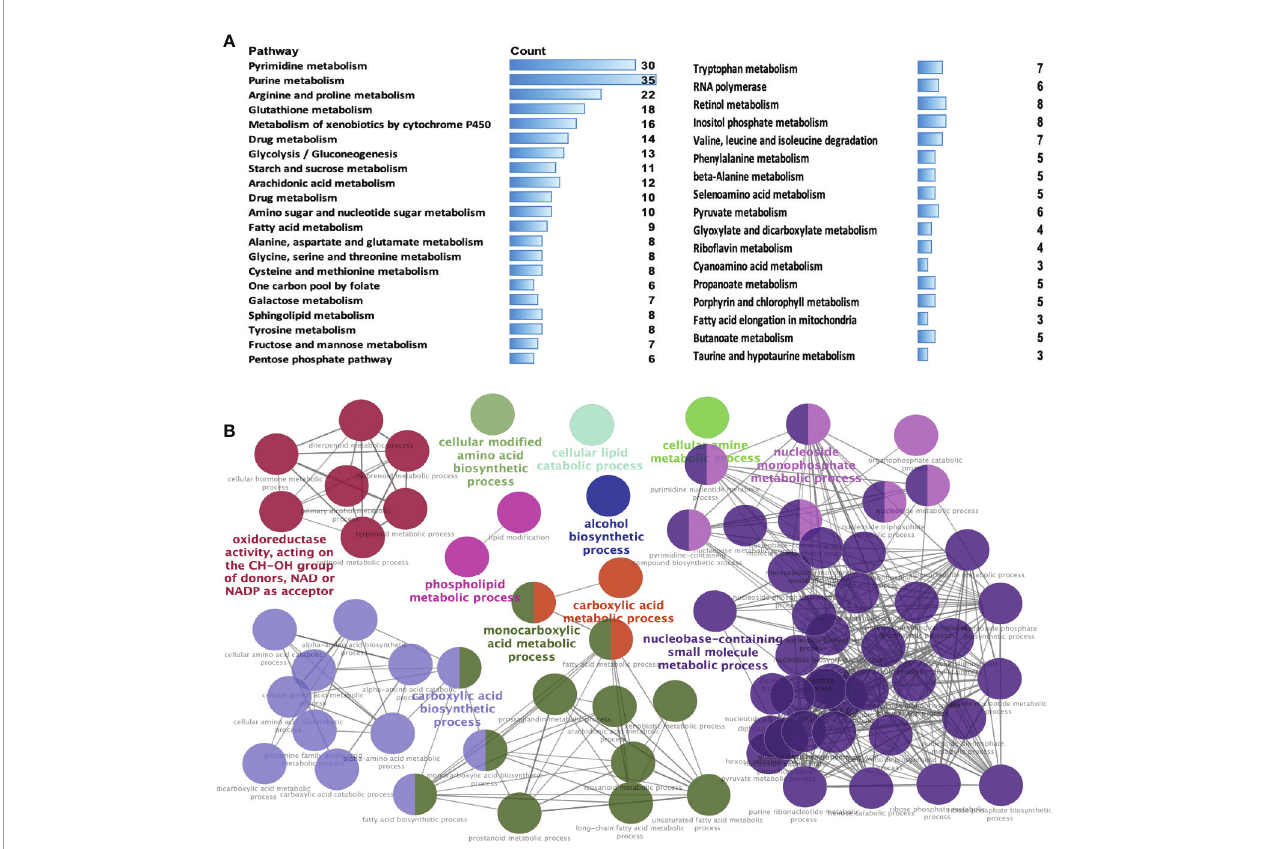
FIGURE 2 | Signi fi cant Kyoto Encyclopedia of Genes and Genomes (KEGG) pathways and biological processes (BPs) of differentially expressed metabolism-related genes (DEMRGs) in stomach adenocarcinoma (STAD). (A) Pathways in cancer signi fi cantly enriched with DEMRGs in SATD (p < 0.05). (B) The DEMRGs were classi fi ed according to the BPs (p < 0.05). The DEMRGs with signi fi cantly enriched in the pathways are shown with a greater node size. Same color indicates the same functional group. A representative group with the most signi fi cant term and lag is